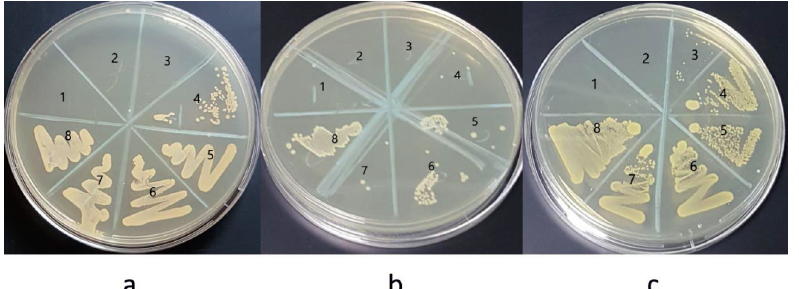
Fig. 7. T. halophilus MBC, (a) Sodium hypochlorite #4 = 8330 µg/ml, (b) Benzalkonium chloride #4 = 34.7µg/ml and (c) Chloroxylenol #2 = 150 µg/ml.